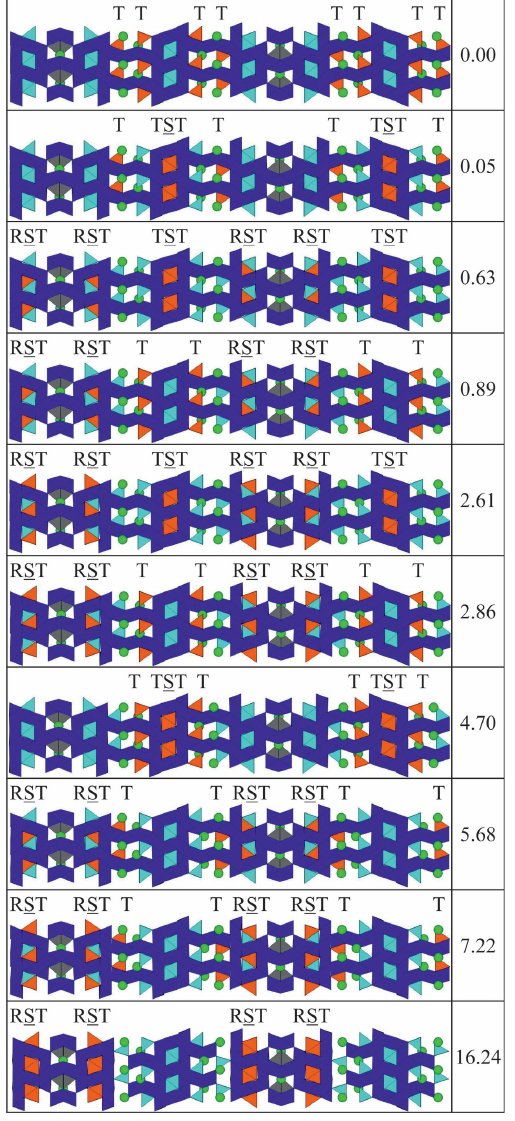
Figure 13 The structures generated by populating Zn atoms in different symmetry- related groups of tetrahedral sites for the (17) 2 hexaferrite, with their computed energies above the most stable configuration in eV. In each structure, the eight zinc atoms are distributed over two groups of symmetry-related tetrahedral sites, each of which contains four tetrahedra (coloured orange). Fe octahedra are shown in dark blue, with bipyramids in grey and tetrahedra in light